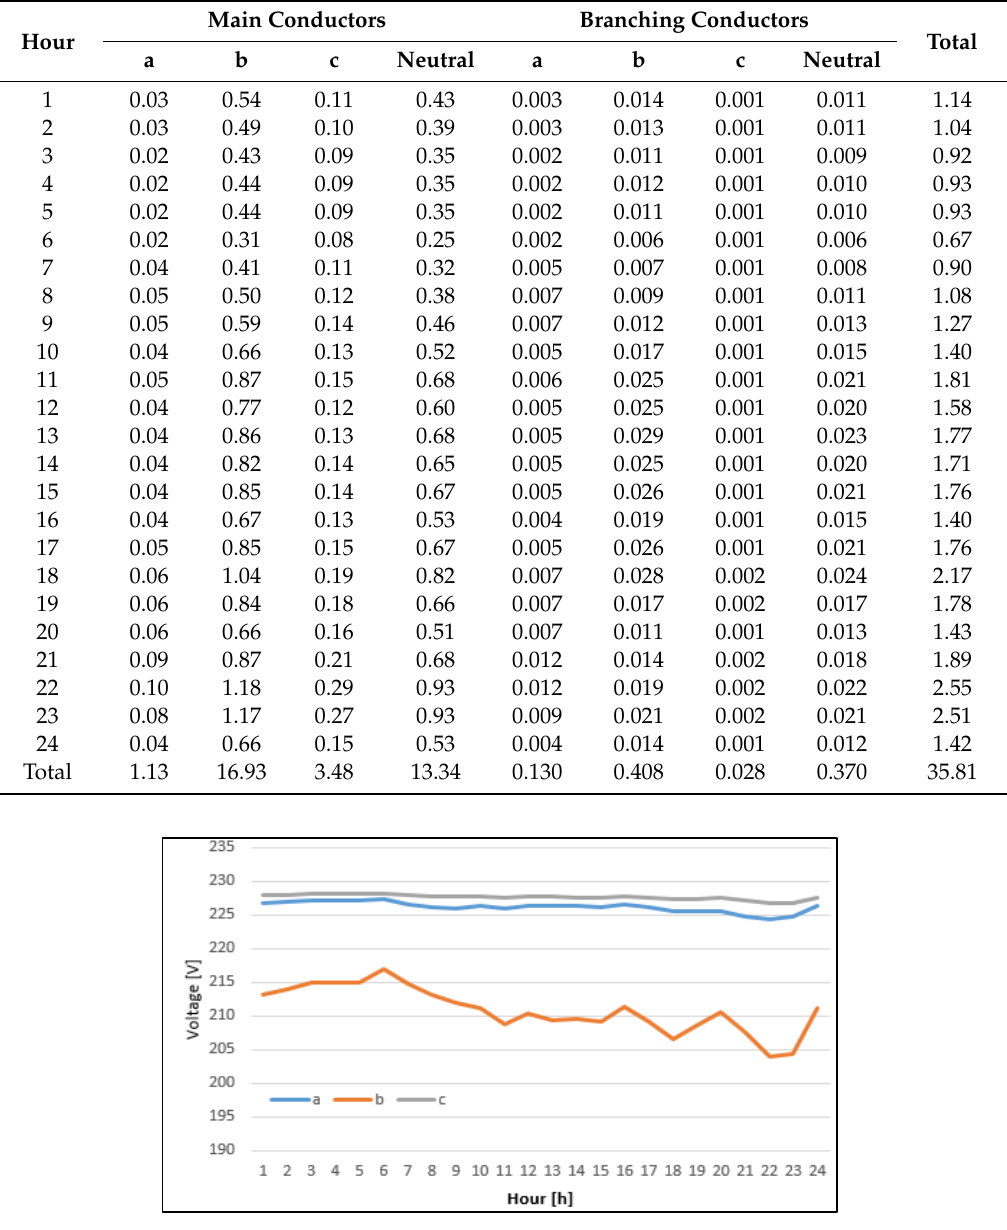
Table 7. The energy losses calculated in the initial case, [kWh].